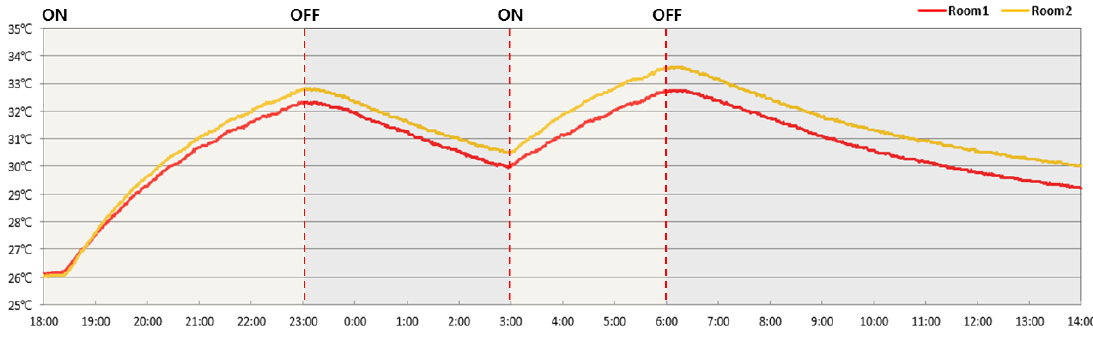
Figure 12. Floor surface temperature over time. Table 9. Temperature on the floor